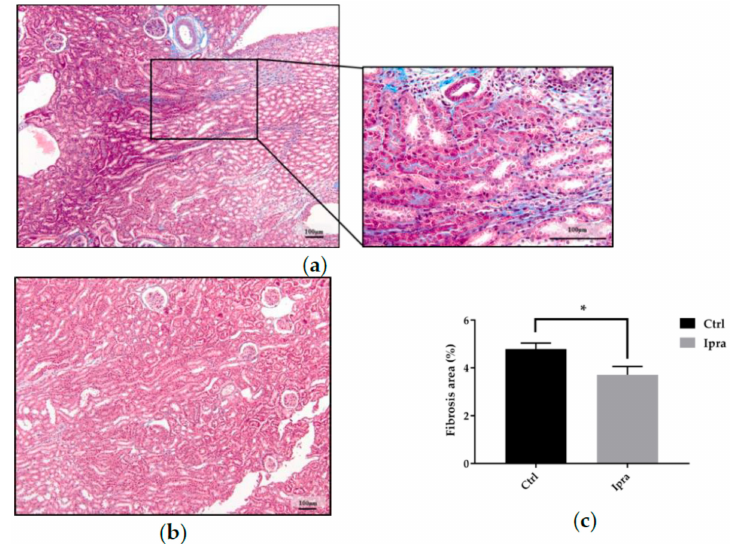
Figure 3. E ff ect of ipragliflozin on interstitial fibrosis. ( a ) Representative images of Masson-trichrome staining on kidney para ffi n-embedded sections from FLS- ob / ob mouse in the control group with a high magnification image. ( b ) Representative image of Masson-trichrome staining on kidney para ffi n-embedded sections from FLS- ob / ob mouse in the ipragliflozin group. ( c ) Quantification of the area of fibrosis. The results were expressed as the percentage of fibrotic area to the whole area. The quantification is based on randomly captured three fields from six di ff erent mice in each group. Bars indicate average ± SEM. * p < 0.05 (unpaired t -test). Ctrl, control group; Ipra, ipragliflozin